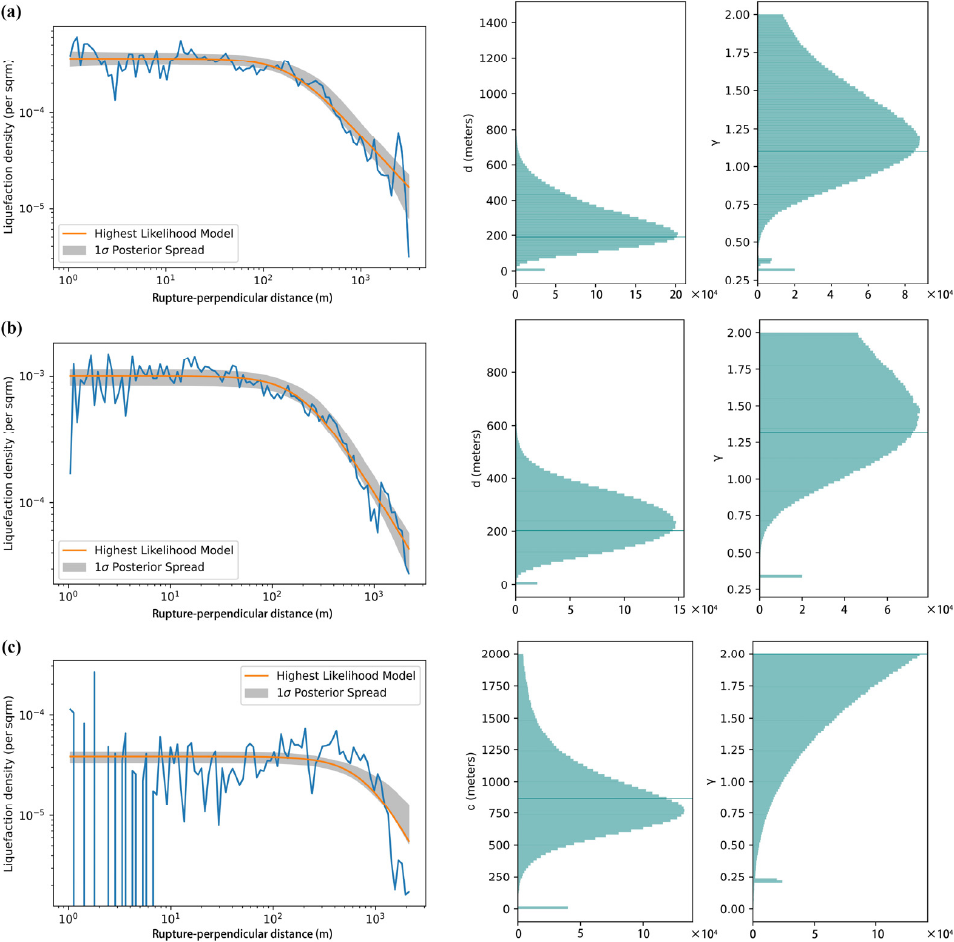
Figure 7. Variation of liquefaction density with increasing distance from the surface rupture in several sections. ( a ) Total study area, ( b ) west of the epicenter, and ( c ) east of the epicenter. The blue line shows the actual trend of liquefaction density with increasing distance from the rupture, the orange line shows the best-fit curve of the trend of liquefaction density, and the gray bar is the 1 σ error. d represents the distance from the surface rupture when the liquefaction density begins to decay, γ is the slope of the decay at distance x >> d